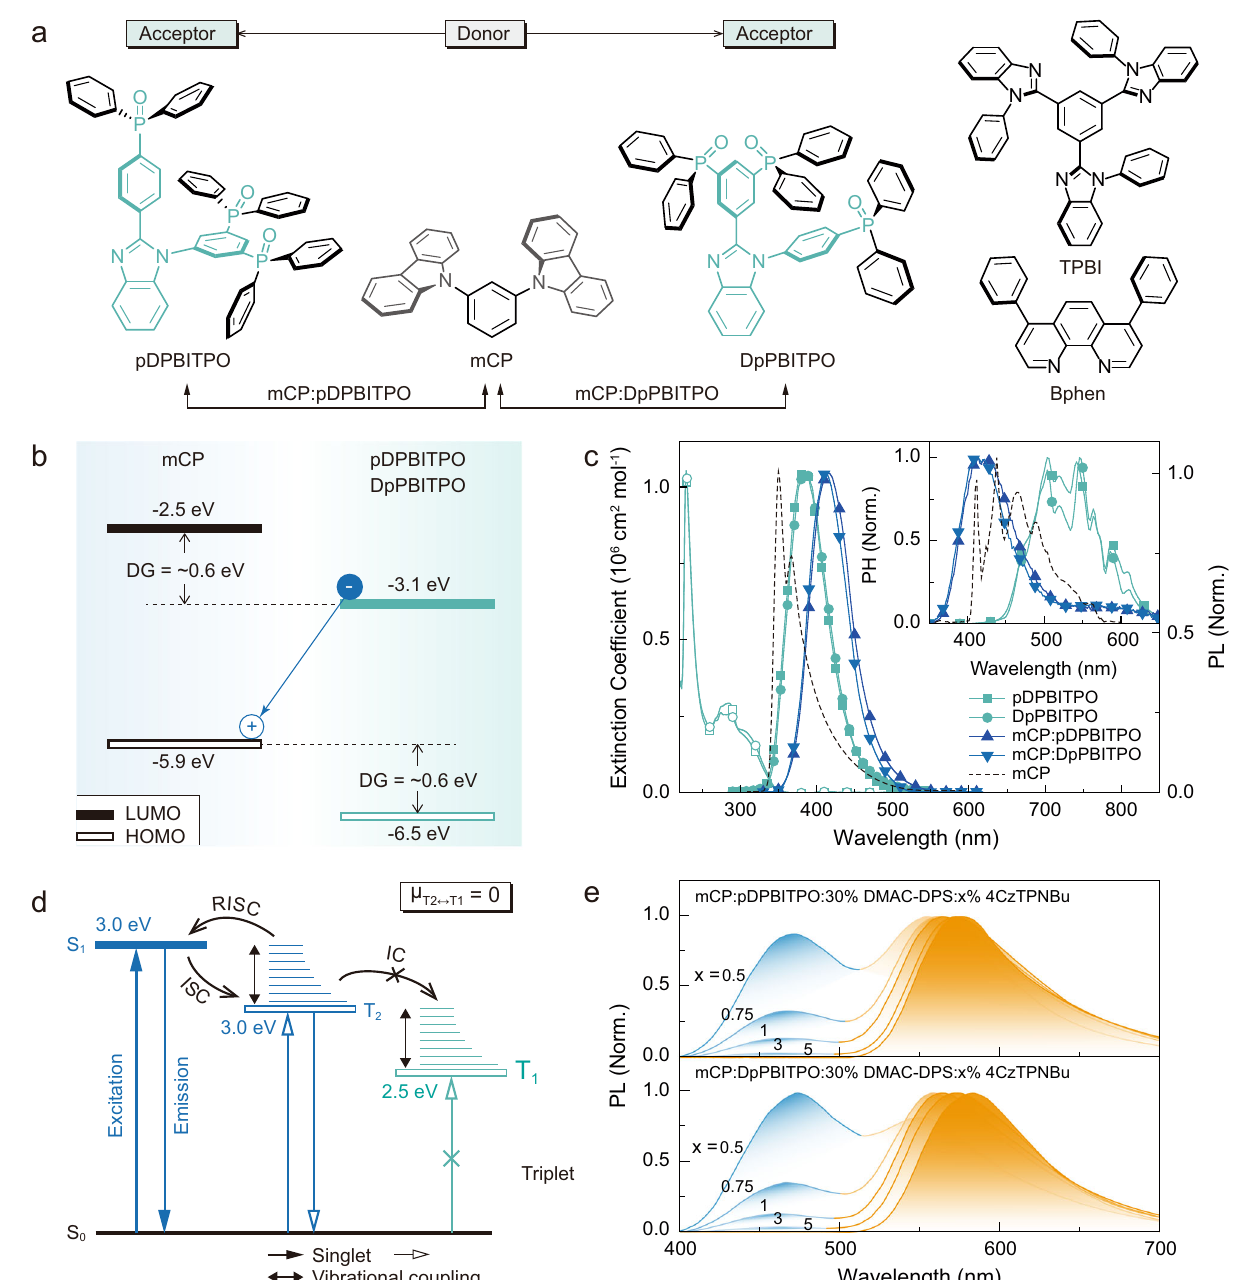
Fig. 2 Structure and energy transition characteristics of the newly developed exciplexes. a Molecular structures of one donor and two acceptors used to form exciplexes mCP:pDPBITPO and mCP:DpPBITPO. Two conventional TPBI and BPhen acceptors were used in device fabrication for comparison. b Frontier molecular orbital (FMO) energy levels of mCP and PO acceptors. Energy gaps of the highest occupied (HOMO) and the lowest unoccupied molecular orbitals (LUMO) between mCP and PO acceptors reach to 0.6 eV, corresponding to the driving force of donor-acceptor electronic coupling ( Δ G). c Electronic absorption of pDPBITPO and DpPBITPO (hollow dots) and steady-state photoluminescence (PL) and time-resolved phosphorescence (PH) spectra of mCP (dash lines), pDPBITPO, DpPBITPO, mCP:pDPBITPO and mCP:DpPBITPO. Phosphorescence spectra were recorded in the time range of 100-200 μ s after excitation. d Jablonski energy level diagram of mCP:PO acceptors. The near-zero energy gap between the S 1 and the mCP-induced T 2 of the exciplex facilitates the RISC through electron and vibrational couplings. Separated T 2 and T 1 locations on mCP and PO acceptors restrain the T 2 → T 1 transition through IC. e Steady-state PL spectra of mCP:pDPBITPO and mCP:DpPBITPO fi lms doped with DMAC-DPS and 4CzTPNBu at different collision-induced quenching at the T 1 state by peripheral DPPO locally excited triplet state and the charge-transfer S 1 state sub- stantially facilitates reverse intersystem crossing (RISC), as evi- groups. Estimated by 0 → 0 transitions in emission spectra, the T 1 (ref. 30 ). Moreover, PO acceptors are superior to conventional energy levels (2.48 eV) of pDPBITPO and DpPBITPO match well low-triplet-energy acceptors with exposed T 1 states, such as TPBI (T 1 = 2.7 eV) and BPhen (T 1 = 2.6 eV), due to prevention of